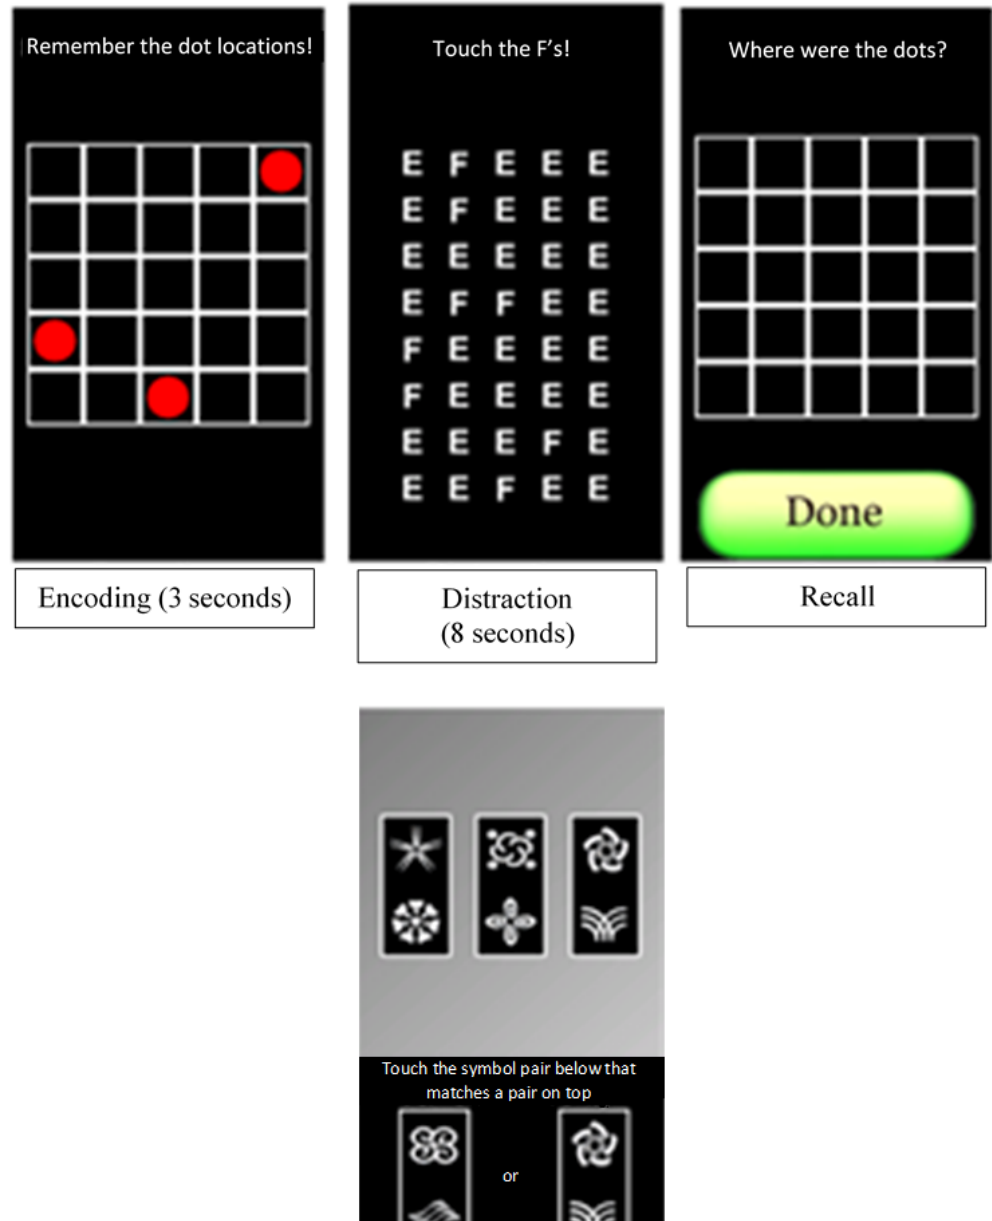
Figure 4. Ambulatory cognitive tests administered via smartphone. Top three images are the spatial memory test (in temporal order), and the bottom image is the processing speed